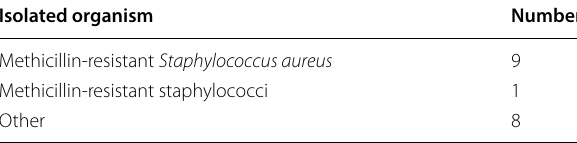
Table 2 Details of culture